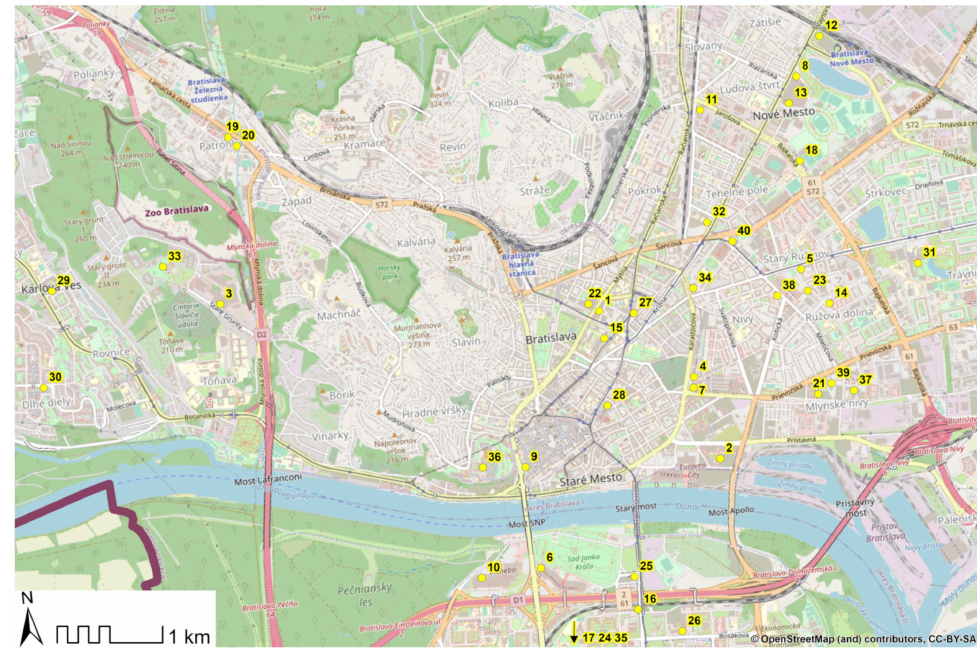
Figure 4. The location of buildings from Table 4.